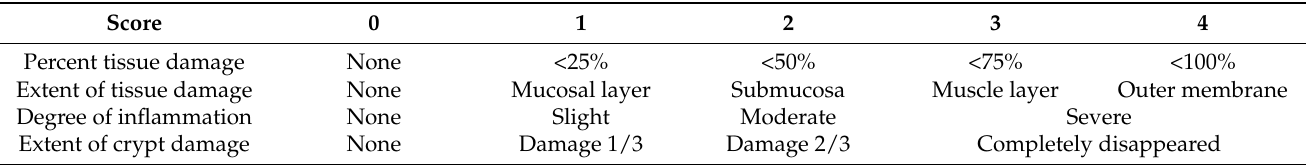
Table 2. The histopathological